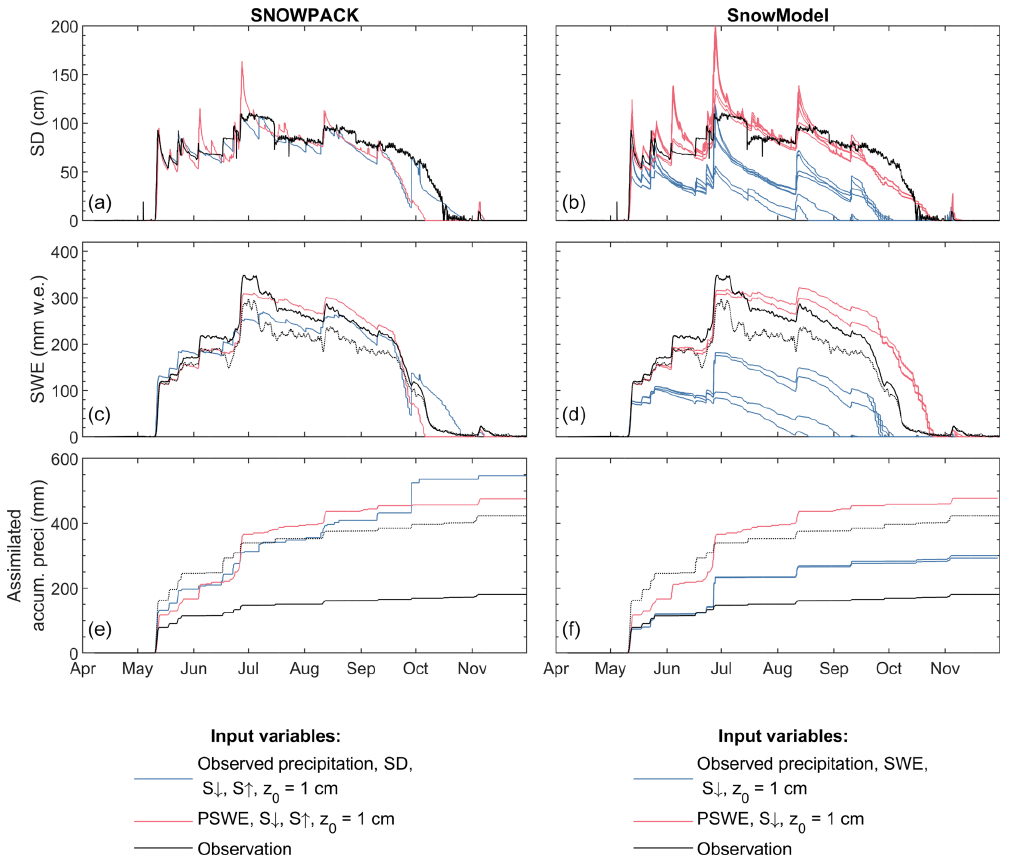
Figure 3. (a, b) SD, (c, d) SWE, and (e, f) the cumulative assimilated precipitation for the simulations with SNOWPACK (a, c, e) and SnowModel (b, d, f) and observations (black). The different input variables are given in the legend. The solid (dotted) line in (c) and (d) indicates the more (less) reliable SWE measurement from potassium (thallium) rays (see Sect. 2.3) and the dotted line in (e) and (f) is P cor . The models have assimilated the observed precipitation (black) to the output (red/blue) given in (e) and (f) . Only one red and one blue line is shown for SNOWPACK as the other eight simulations crashed. The simulations for z 0 = 1mm are found in Sect.